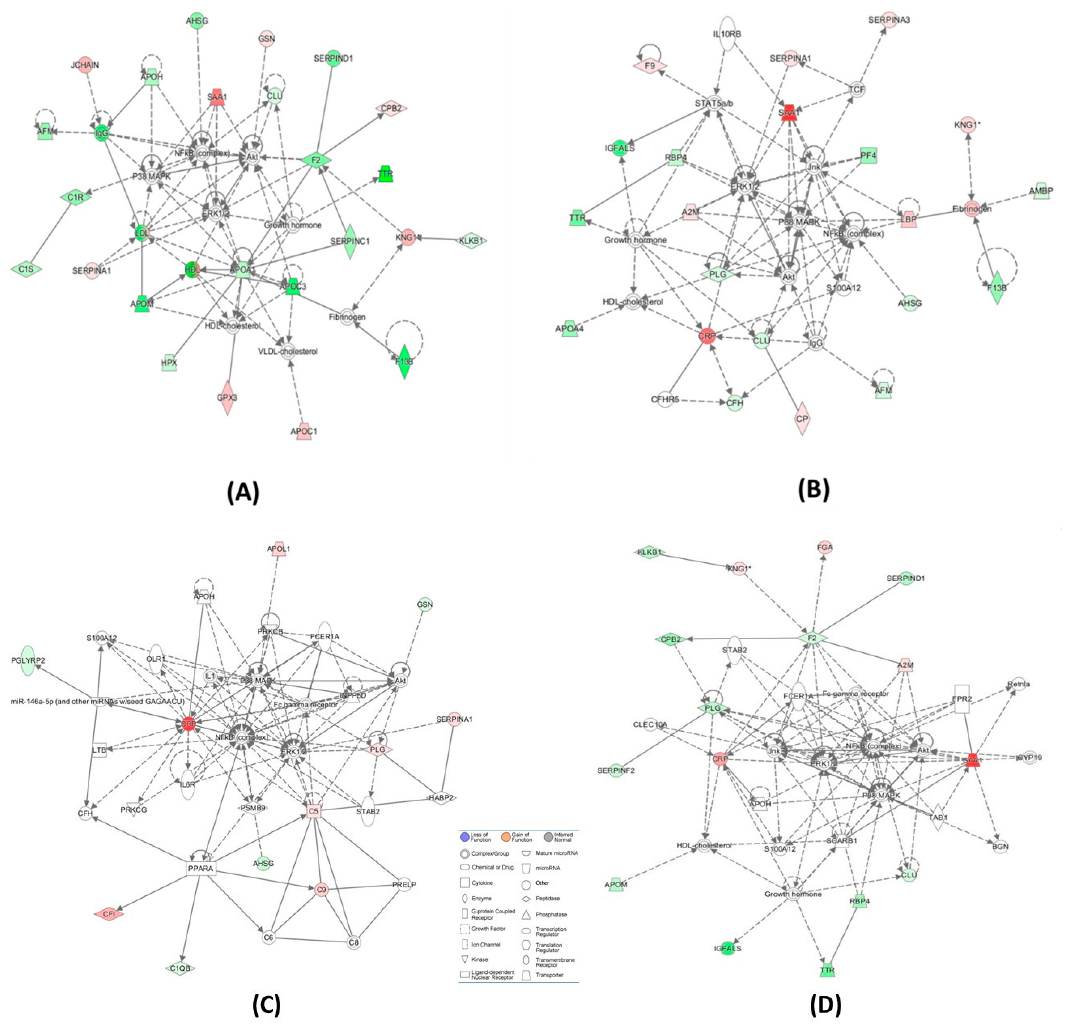
Figure 3. Top molecular networks associated with CBS deficiency and ischemic stroke subtypes: ( A ) CBS deficiency: humoral immune response, inflammatory response, developmental disorder; ( B ) cardioembolic vs. lacunar: cell-to-cell signaling and interaction, hematological system development and function, neurological disease; ( C ) large-vessel vs. lacunar: inflammatory response, cellular movement, immune cell trafficking; ( D ) cardioembolic vs. large-vessel: metabolic disease, hematological system development and function, lipid metabolism. Upregulated and downregulated proteins are highlighted in red and green, respectively.